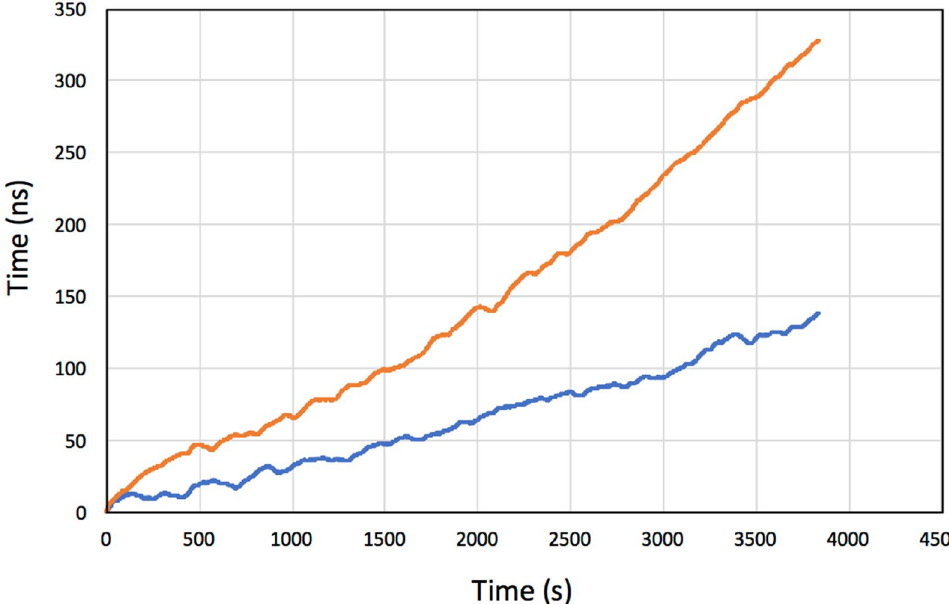
Figure 3. Averaged current OCXO time offset (<Δ t >) (blue lines) and the standard deviation (SD) of σ( t ) (orange lines) as a function of